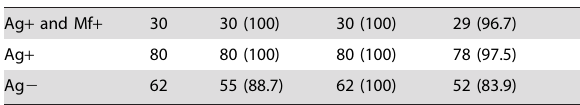
Table 4. Antibody response by infection